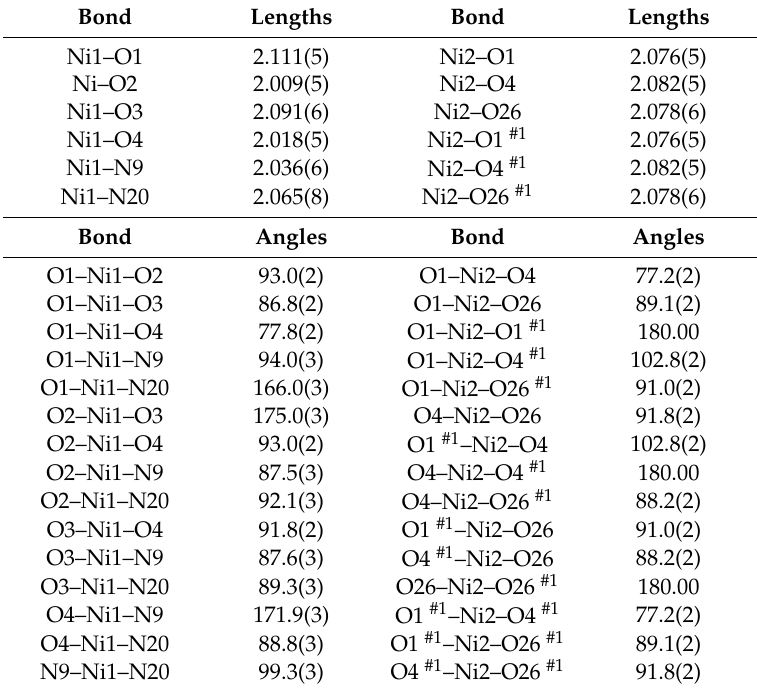
Table 3. Bond lengths (Å) and angles ( ◦ ) of the Ni(II) complex.